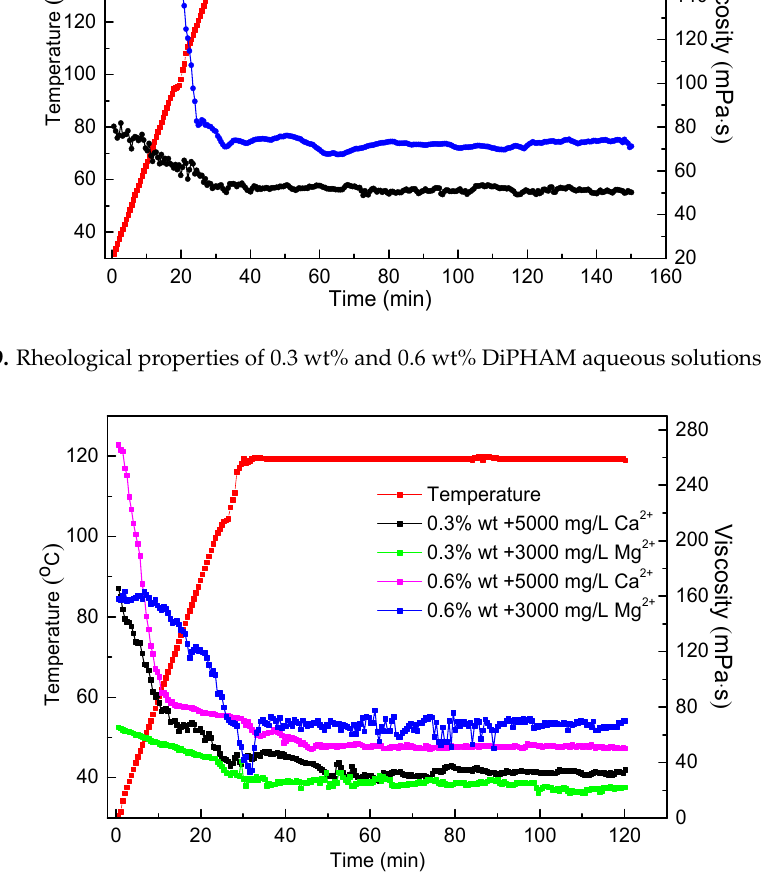
Figure 20. Rheological properties of 0.3 wt% and 0.6 wt% DiPHAM aqueous solutions with different concentrations of Ca 2+ and Mg 2+ ions.